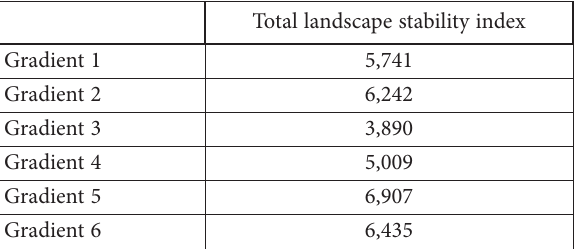
Table 3. Gradient’s stability index (source: by the authors)